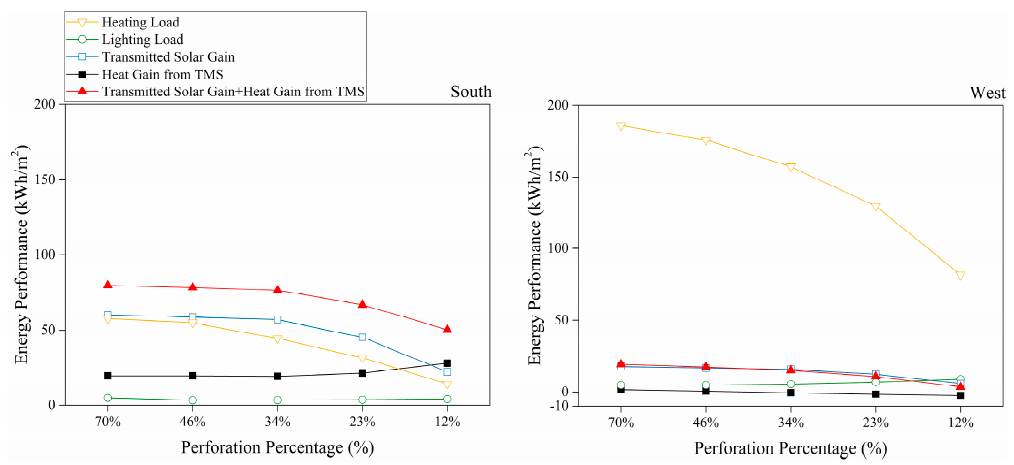
Figure 5. Winter energy performance of different perforated percentages in Group 2.